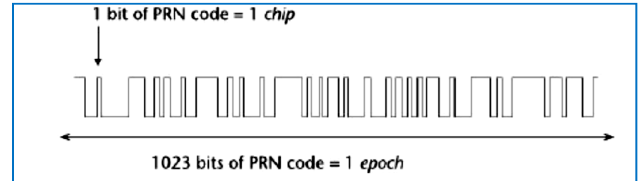
Figure 1. PRN code, chips, and epoch.